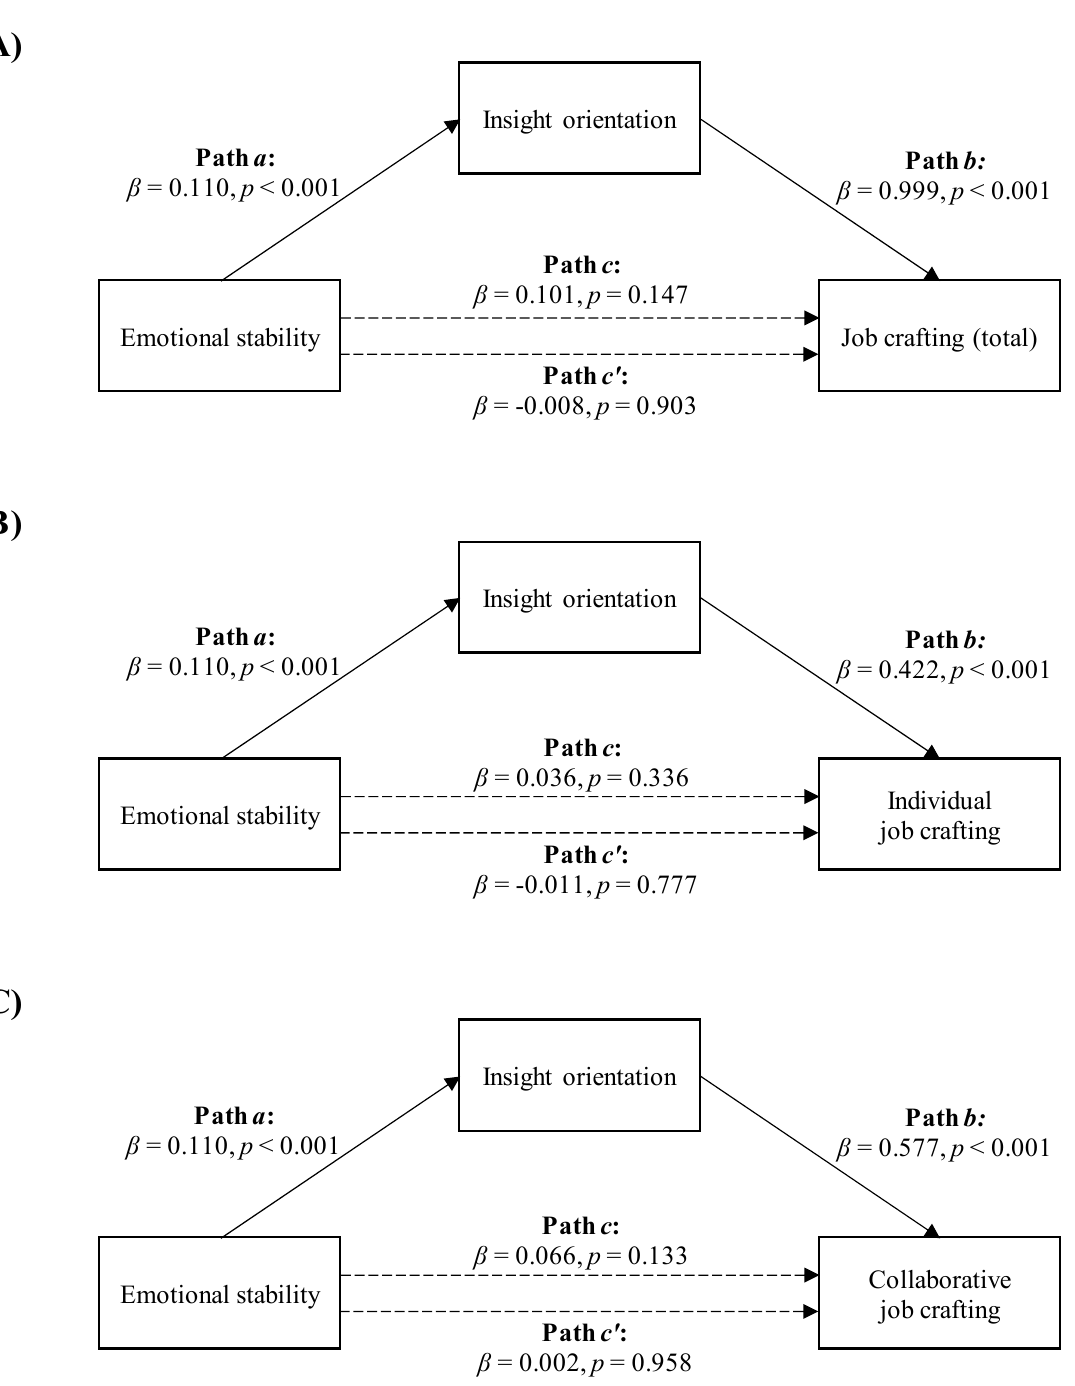
Figure 4. The mediation of insight orientation in the relationships between emotional stability and total job crafting score: ( A ) no mediation, individual job crafting; ( B ) no mediation or collaborative job crafting; ( C ) no mediation.